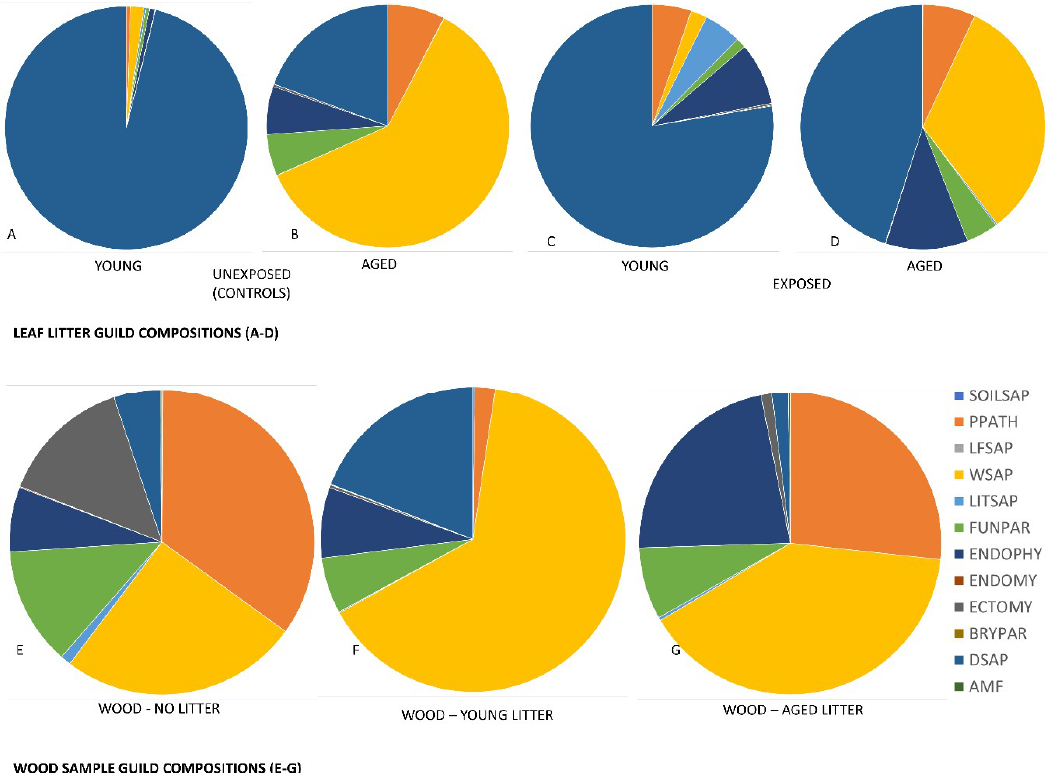
Figure 6. Guild composition of fungi under 7 different exposure scenarios. ( A ) Young litter prior to exposure, ( B ) aged leaf litter prior to exposure, ( C ) young litter after exposure, ( D ) aged litter after exposure, ( E ) wood with no leaf litter in contact, ( F ) wood exposed to young leaf litter, and ( G ) wood exposed to aged leaf litter. Note differences in relative proportion of fungal guilds and increased proportion of wood saprophytes (WSAP) between young and aged litter and wood exposed to both young and aged litter. Functional guild assignments performed using FungGuild [52]. Figure legends to the right are defined in the text.